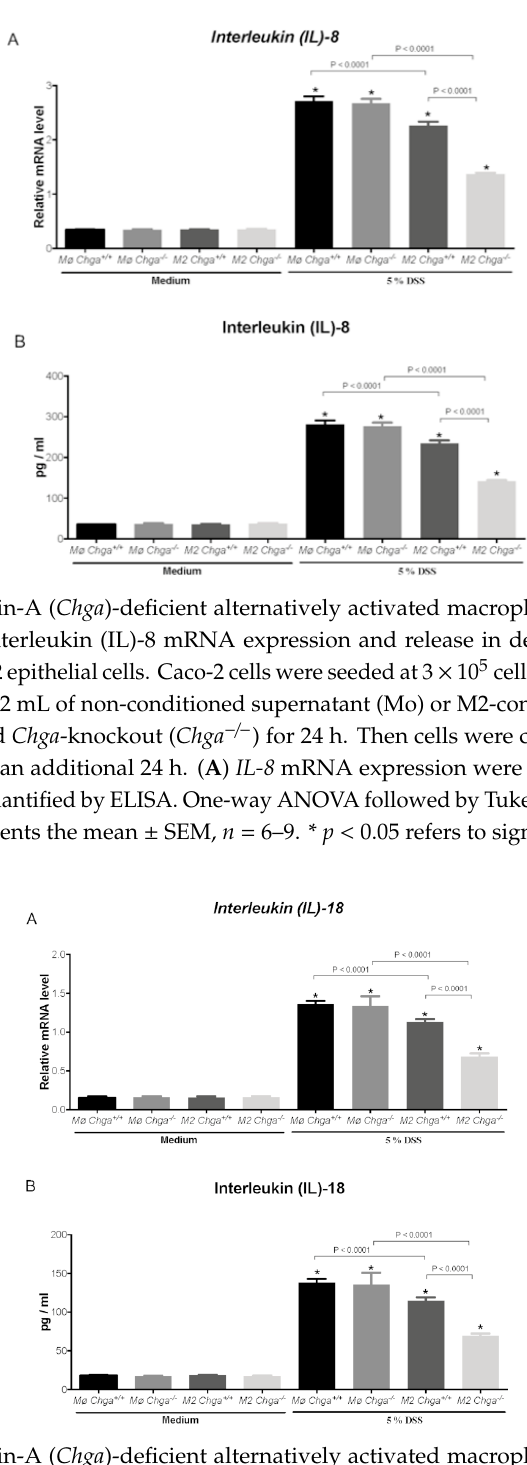
Figure 7. Chromogranin-A ( Chga )-deficient alternatively activated macrophages (M2)-conditioned supernatant reduces interleukin (IL)-18 mRNA expression and release in dextran sulphate sodium (DSS)-stimulated Caco-2 epithelial cells. Caco-2 cells were seeded at 3 × 10 5 cells / well onto tissue culture plates and treated with 2 mL of non-conditioned supernatant (Mo) or M2-conditioned supernatant of wild-type ( Chga +/+ ) and Chga -knockout ( Chga − / − ) for 24 h. Then cells were challenged with 5% DSS or regular medium for an additional 24 h. ( A ) IL-18 mRNA expression were quantified by RT-qPCR; ( B ) IL-18 releases were quantified by ELISA. One-way ANOVA followed by Tukey’s multiple comparison tests. Each value represents the mean ± SEM, n = 6–9. * p < 0.05 refers to significance compared with medium groups.